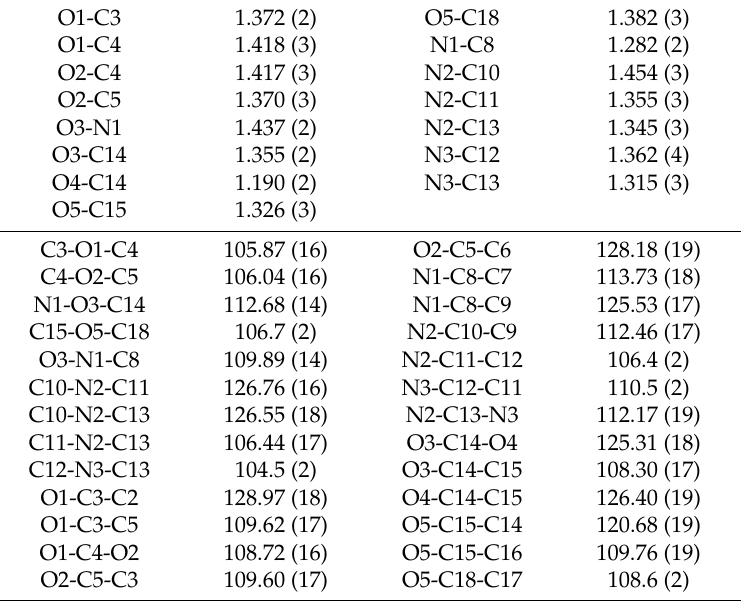
Figure 1. ORTEP diagram of the oximino ester 5 drawn at 40% ellipsoids for non-hydrogen atoms. Table 2. Selected geometric parameters (Å, °) of the oximino ester 5 .